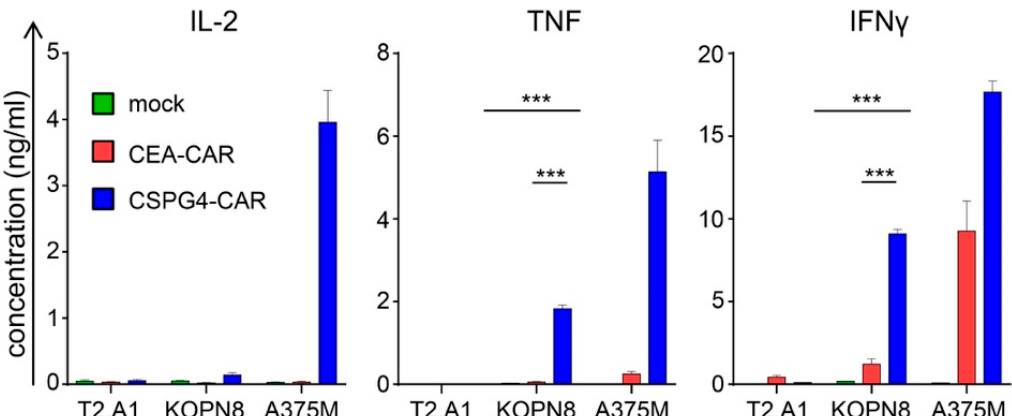
Figure 3. CSPG4-CAR T cells antigen-specifically produce Th1 cytokines in response to stimulation with KOPN8 leukemia cells. The different T cell conditions were generated as mentioned above (Figure 2). Mock (no RNA)-electroporated T cells and CEA-CAR T cells served as negative controls. Twenty-four hours after electroporation, T cells were co-incubated over-night at a 1:1 ratio with T2.A1 cells, KOPN8 cells, and A375M cells. Induced cytokine secretion was quantified in the supernatant with a cytometric bead array (CBA). Concentrations of IL-2, TNF, and IFN γ are depicted [ng/ml]; please note the different scales. Data represent means ± SEM from three independent experiments, p values were calculated by paired t test, *** indicates p ≤ 0.001.